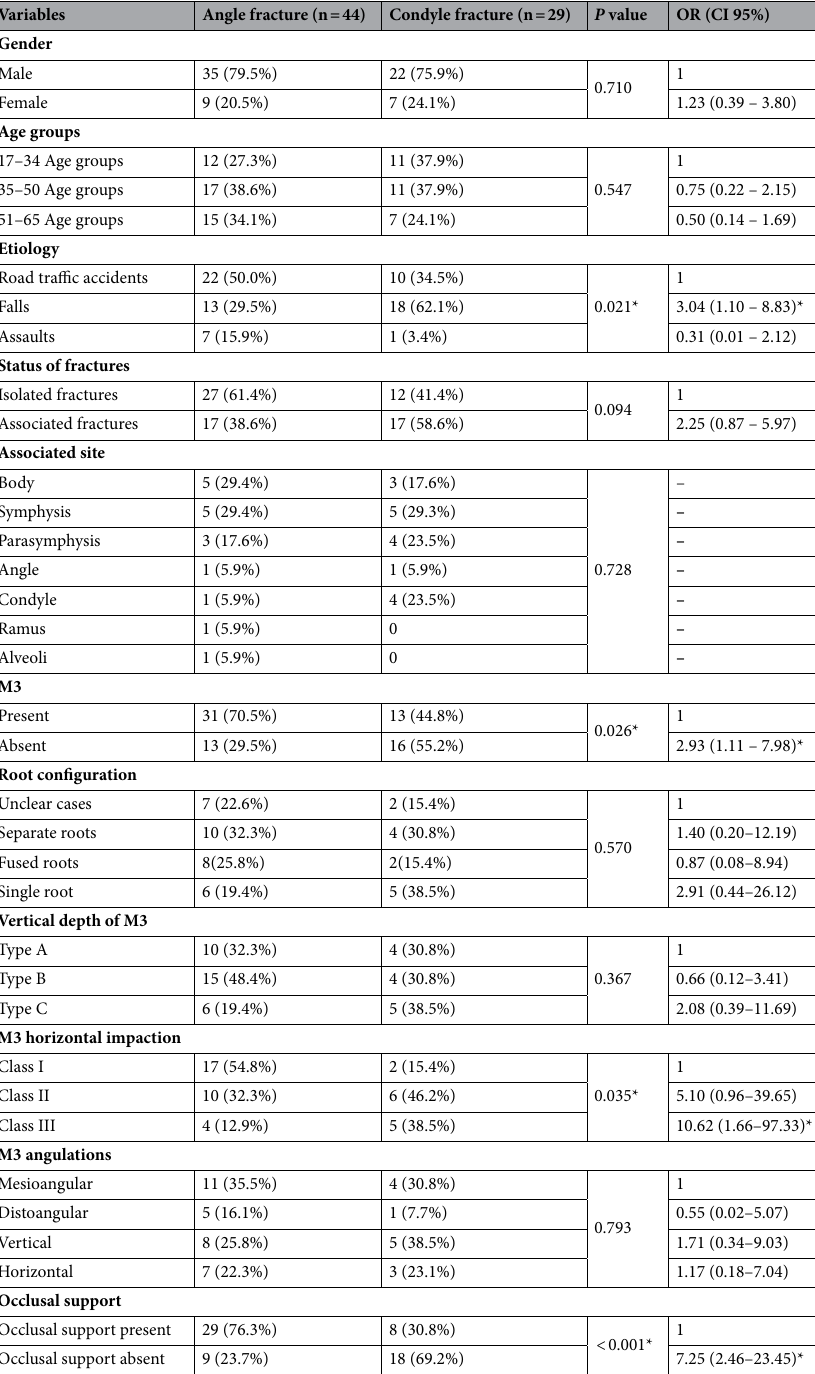
Table 1. Univariate Analysis of Related Factors of the mandibular fractures (angle and condyle fractures). *Means significant statistical difference.